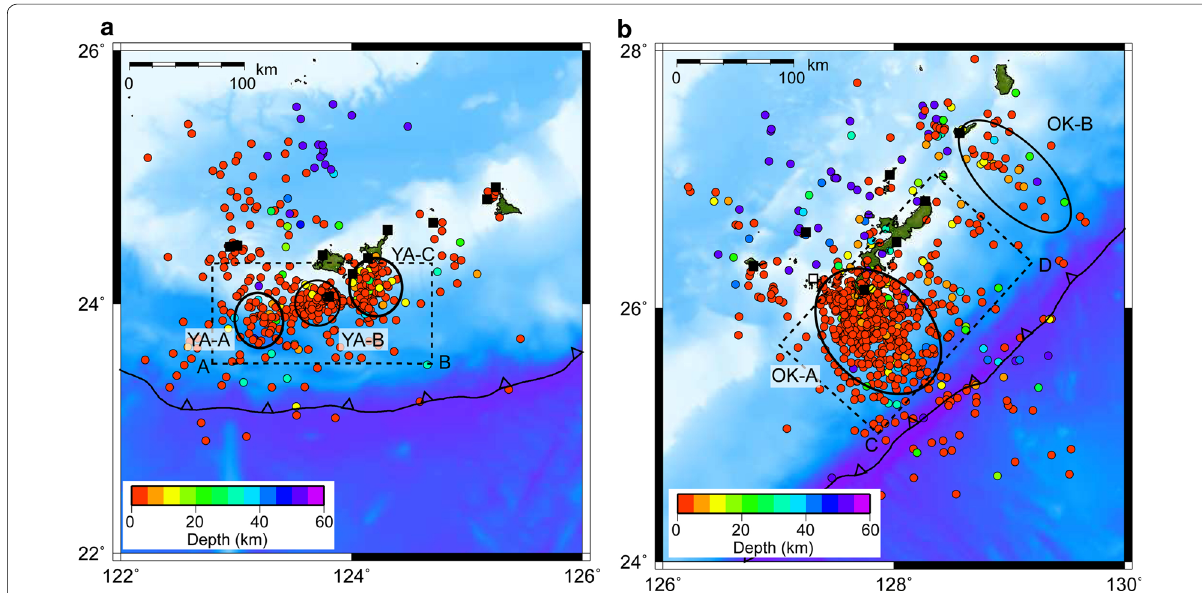
Fig. 6 Distributions of low-frequency earthquakes (LFEs) in the southern and central Ryukyu Trench. a Distribution of LFEs in the Yaeyama area. Circles show the epicenters of LFEs. Solid squares show the JMA stations used in the hypocenter determination. Black circular areas show the clusters of the LFEs. Rectangular area with dotted line denotes the area from which the time–space diagram in Fig. 10 was constructed. b Distribution of the LFEs in the Okinawa area. Solid and open squares show the JMA and F-net stations, respectively, used in the hypocenter determination. Rectangular area with dotted line denotes the area from which the time–space diagram in Fig. 9 was